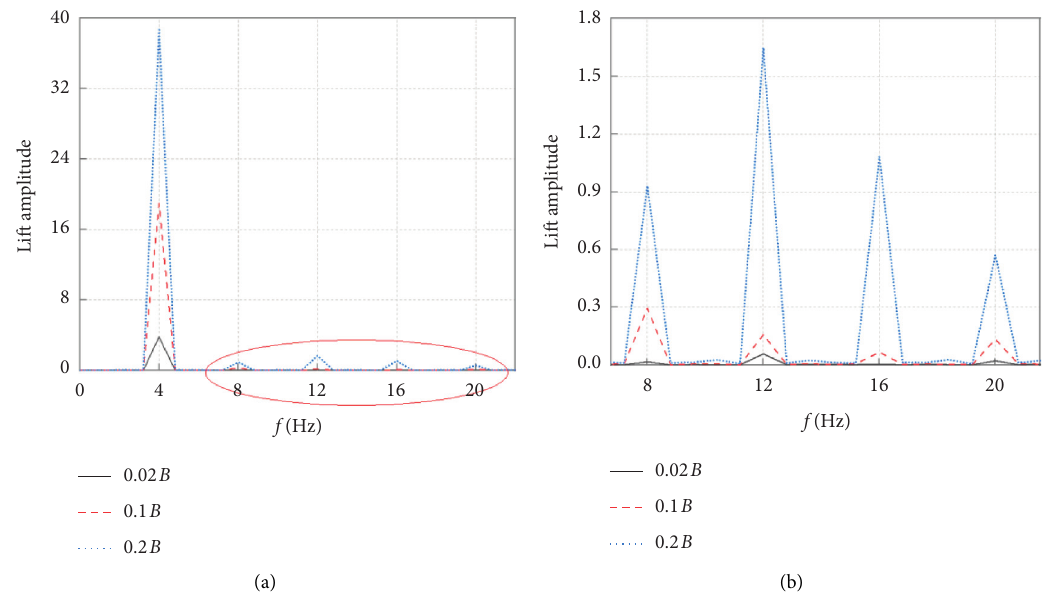
Figure 9: Aerodynamic lift spectrum under different vertical amplitude vibrations of the single frequency. (a) Complete spectrum. (b) Locally amplified